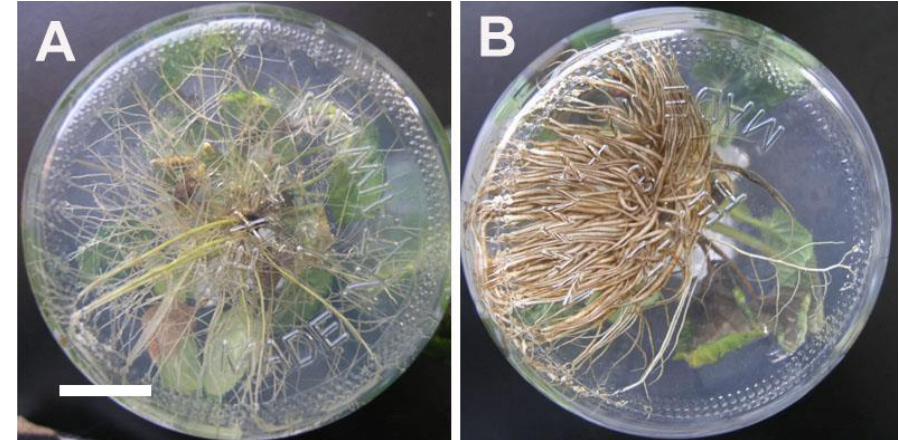
Figure 3. Growth and morphological responses of 2 x and 4 x plants of Salvia miltiorrhiza in vitro (bar = 2 cm for all figures). ( A ) 2 x plant. ( B ) 4 x plant.